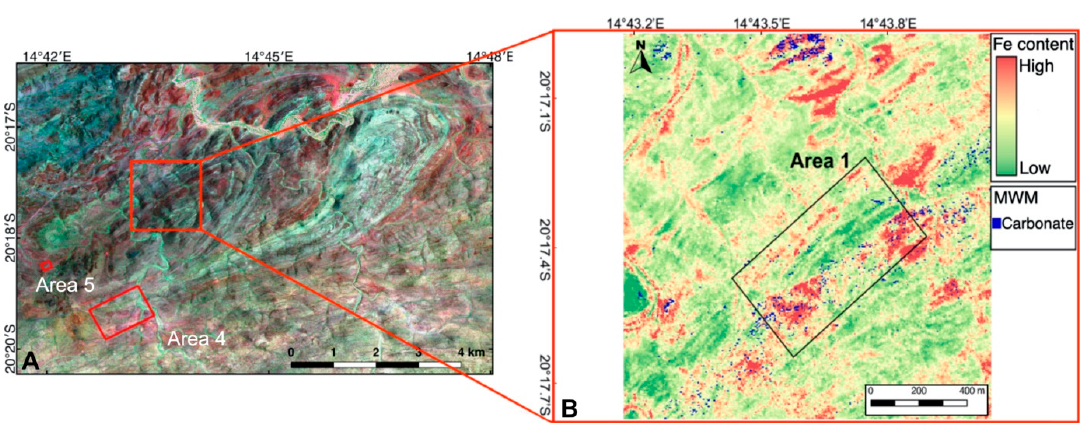
Figure 10. ( A ) False color composite HyMap image indicating the areas which have been surveyed with RPAS in red. ( B ) Band ratio performed on the main area of interest (764 nm / 458 nm) enhancing the iron absorption feature in red as well as minimum wavelength mapping (MWM) of carbonate absorption features at 2335 nm in blue. Selected area for RPAS-based survey encircled in black. Remote Sens. 2019 , 11 , x FOR PEER REVIEW The selected area contains numerous thin dykes. To map the dykes in this area, a better